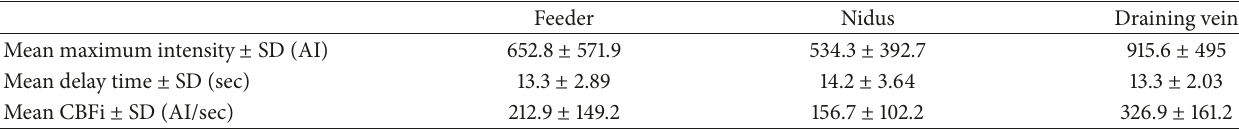
Figure 3: Case 3. DSA revealed the presence of AVM in the right parasagittal postcentral region (a, b). Intraoperative photograph at after dural opening demonstrating restricted exposure of the AVM (c). Delay map using FLOW800 showed poor performance in demonstrating the accurate structure of the entire AVM (d). Table 2: Mean value of each parameters regarding vessel type. Feeder Nidus Draining vein